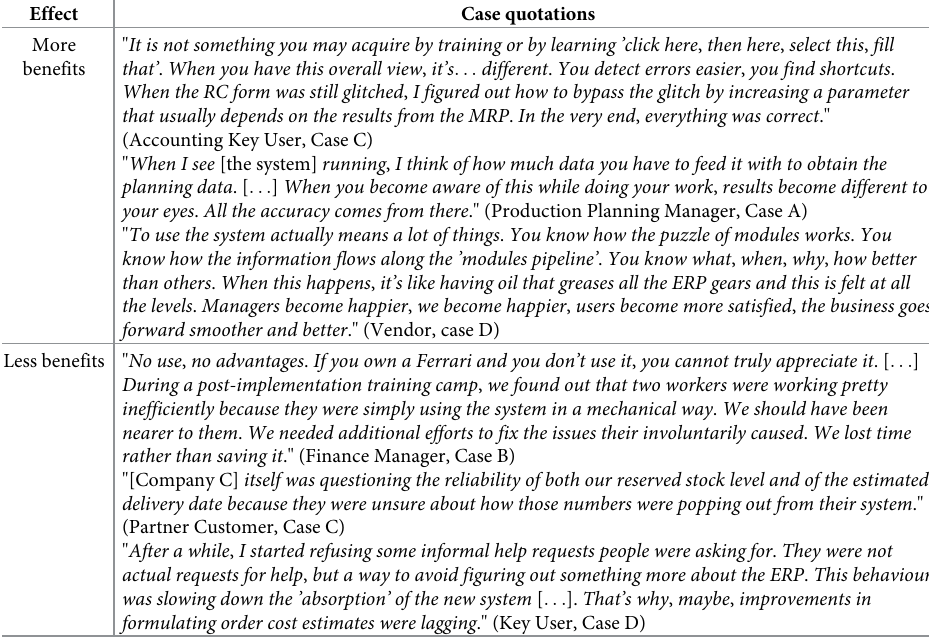
Table 6. Examples of case quotations on the enhanced interaction-benefits causal relationship over